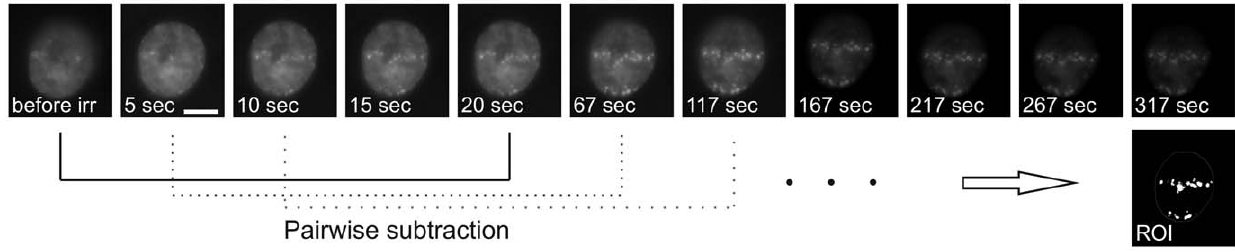
Figure 1. Parts of a micrograph time series of a U2OS cell nucleus showing GFP-tagged protein Mdc1. Irradiation took place on t =0. Foci formation can be observed already a few seconds after irradiation. Pairwise subtraction of the images reveals areas where foci are formed. The merge of these areas results in the region of interest (ROI) in which the foci brightness I foci is evaluated for each image of the time series (cf. materials and methods). Scale bar in second image: 5 m m.